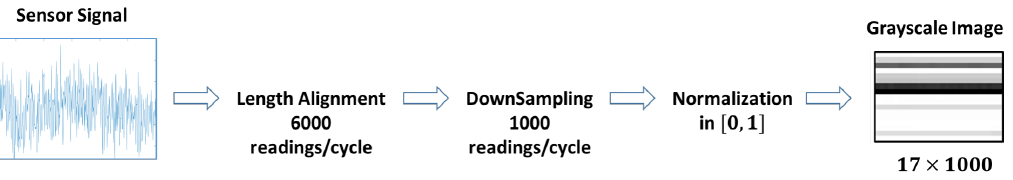
Figure 3. Data preprocessing of sensor